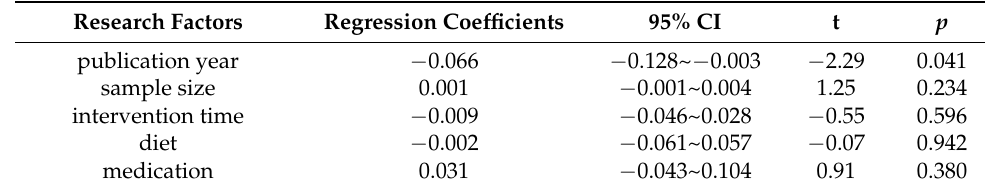
Table 2. Meta regression analysis of heterogeneous factors of TG.